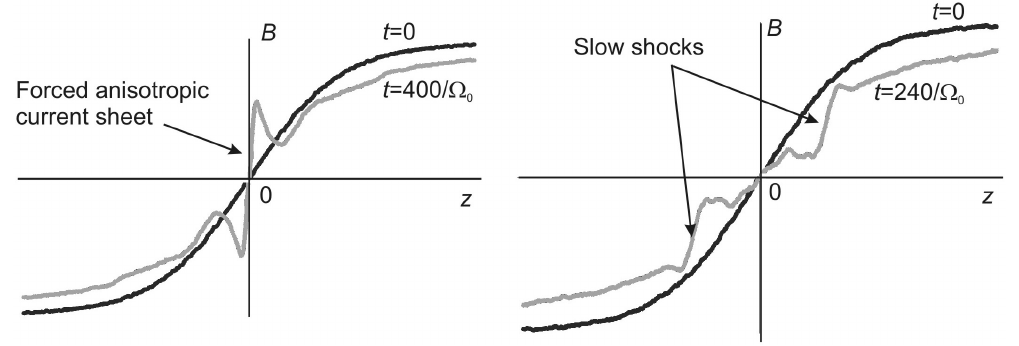
Fig. 1. Examples of the simulation results: calculated field profiles.